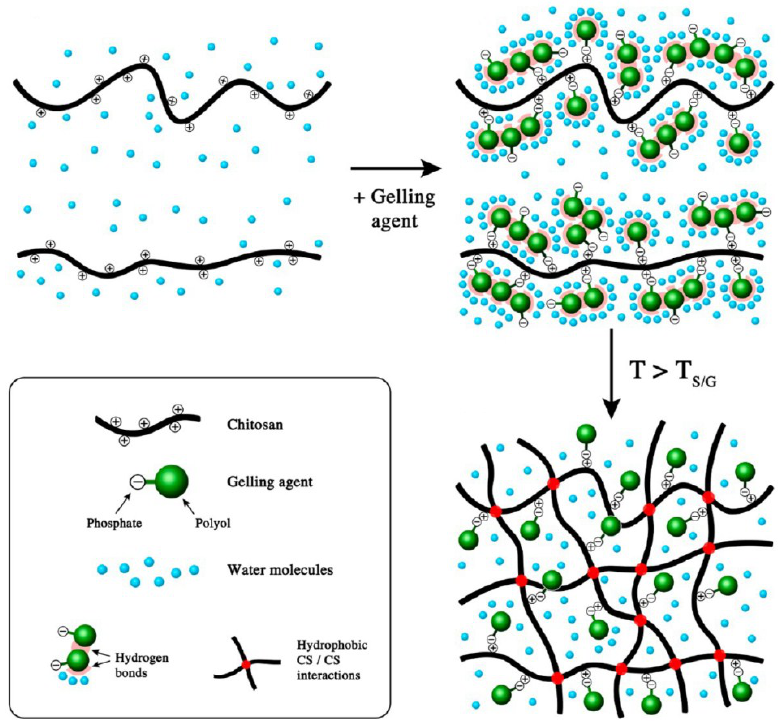
Figure 6. Gelling mechanism of chitosan polyol-phosphates solutions. Adapted with permission from [101], Copyright 2013 American Chemical Society. from [101], Copyright 2013 American Chemical